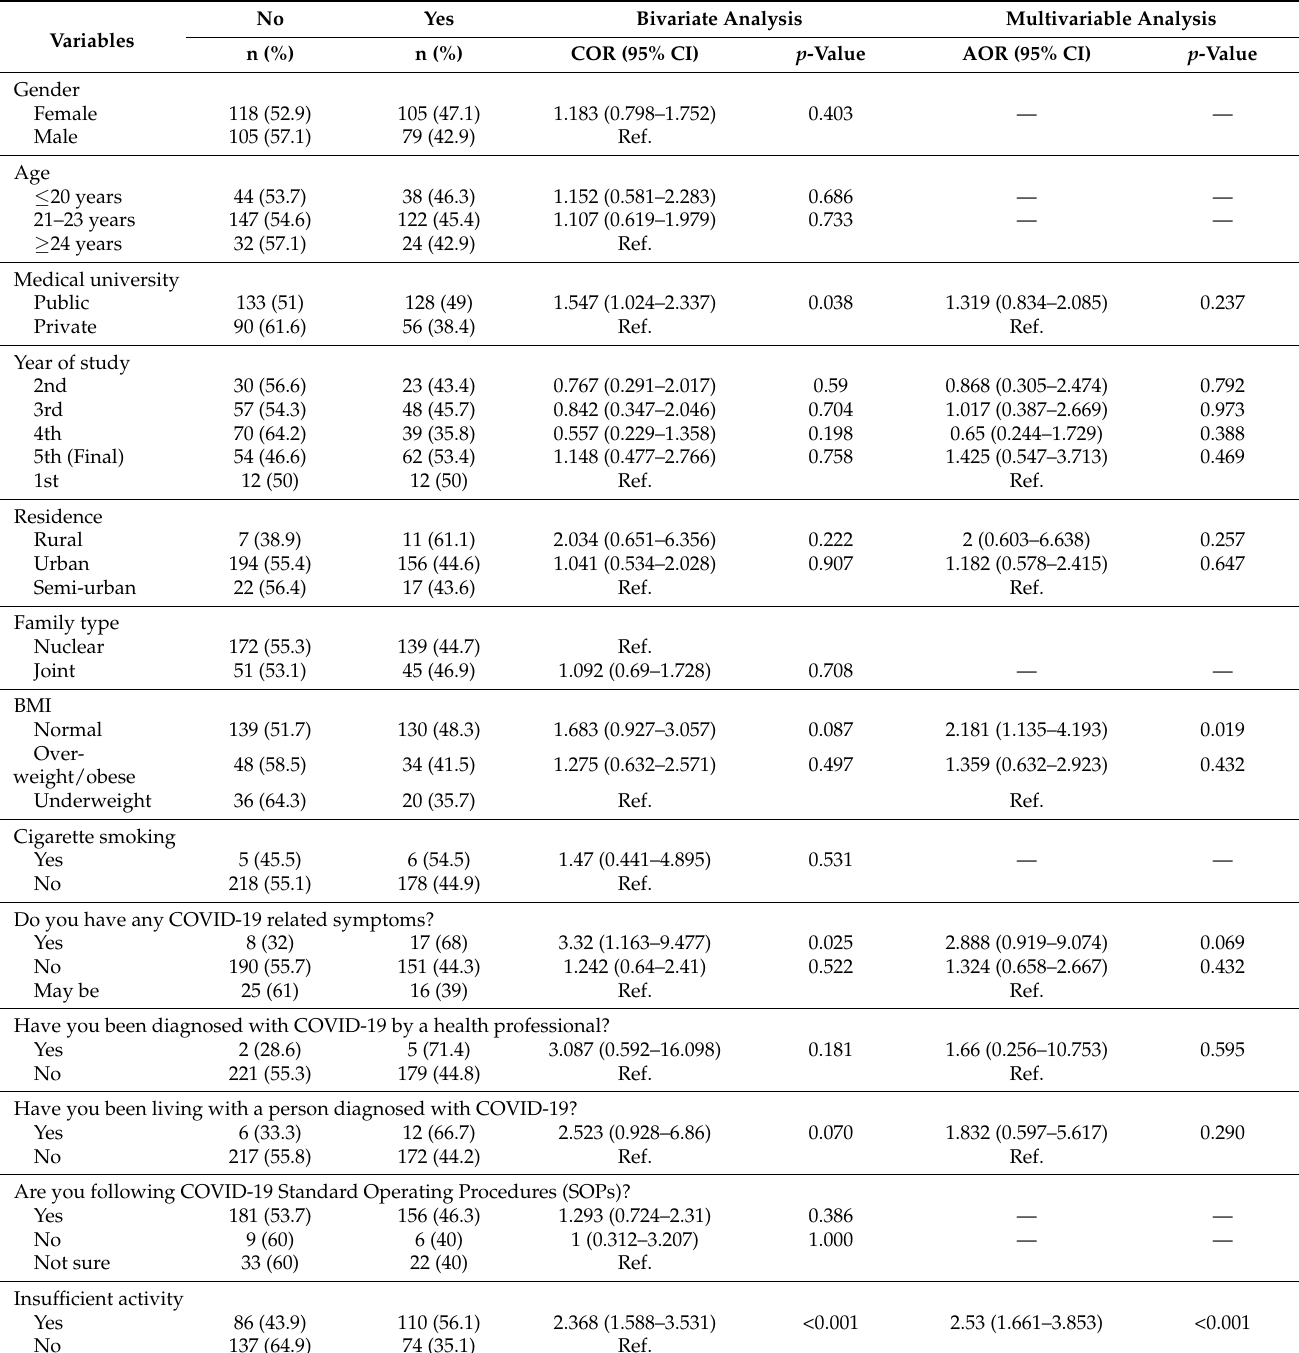
Table 2. Regression analysis predicting sedentary